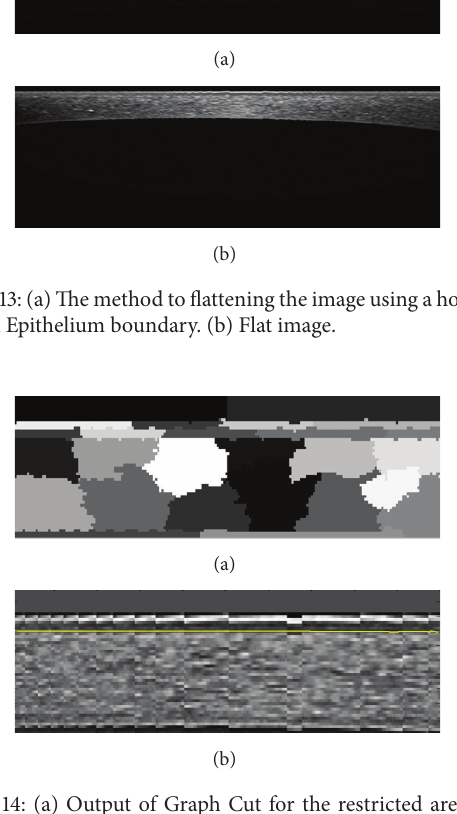
Figure 14: (a) Output of Graph Cut for the restricted area to the Bowmanboundary.(b)Bowmanboundaryestimationinthemiddle based on the Epithelium